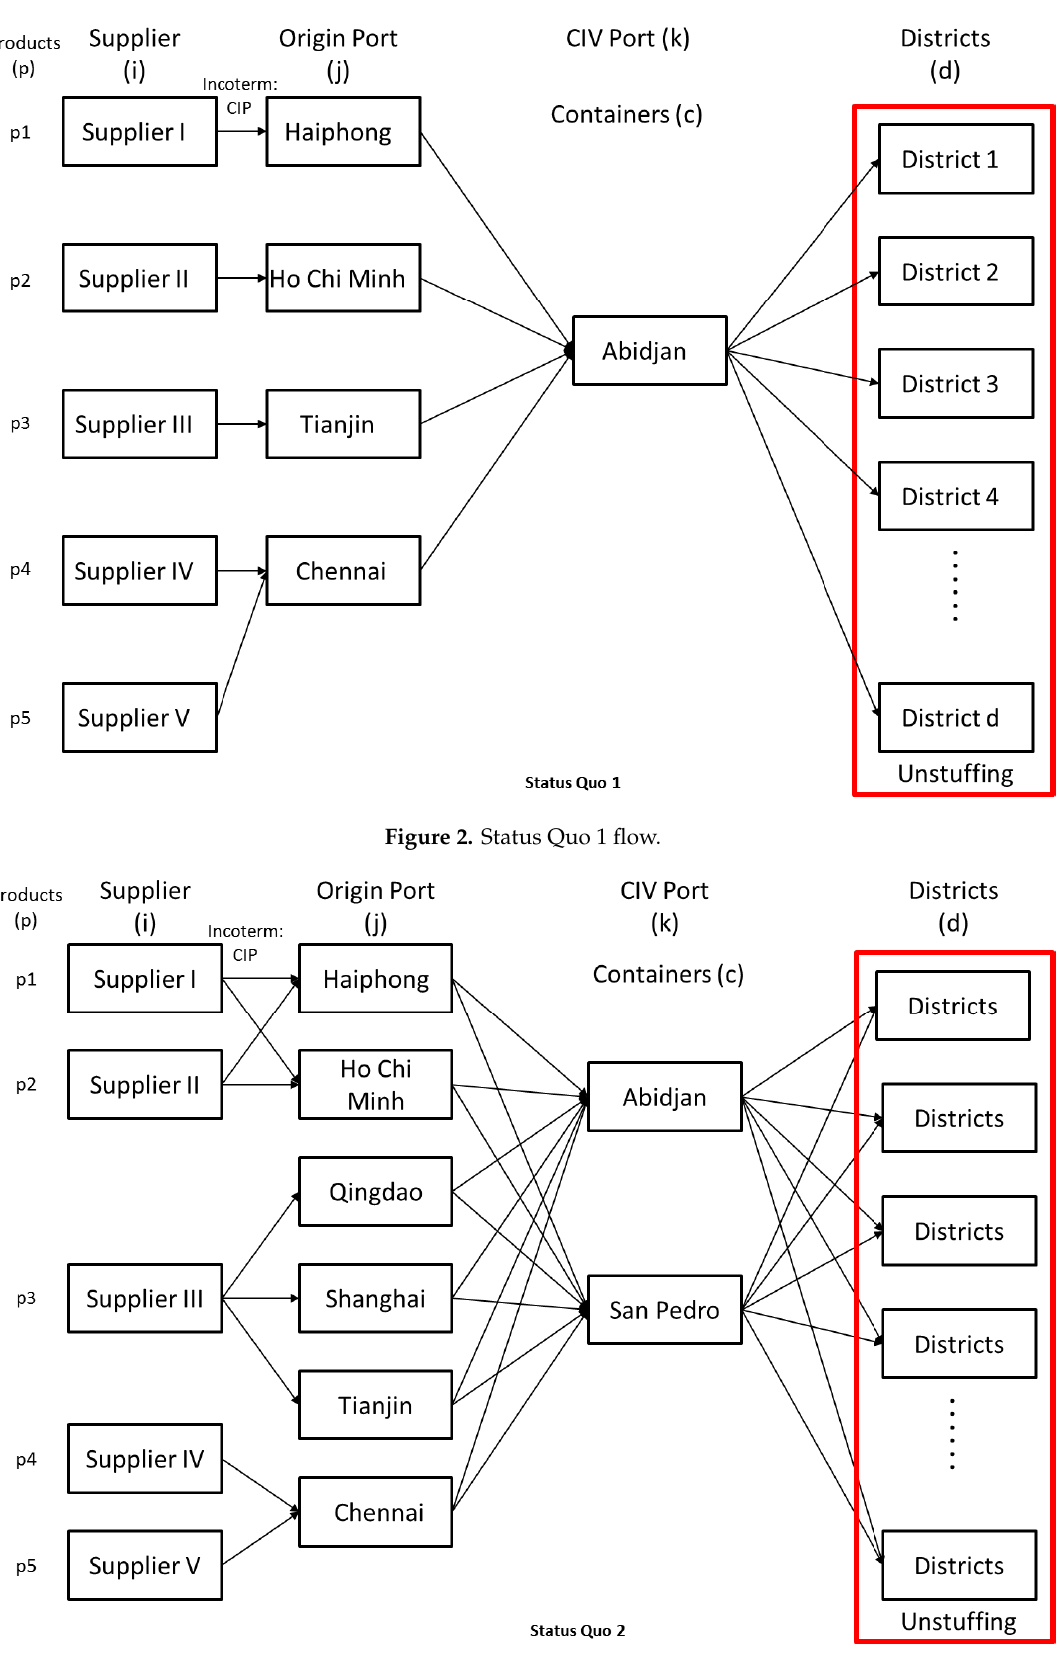
Figure 3. Status Quo 2 flow.